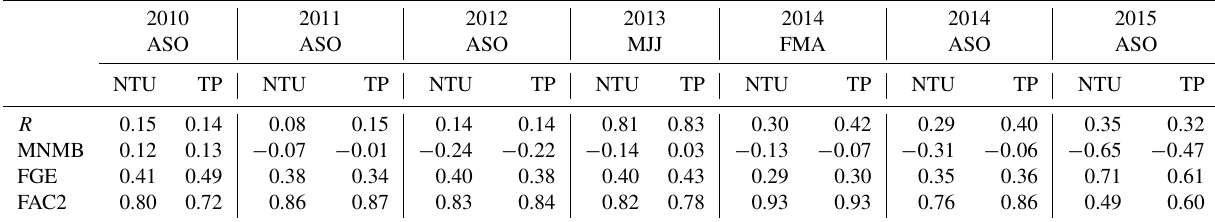
Table 4. Statistics for PM 10 , for both the western (NTU) and eastern (TP) monitoring stations, for selected 3-month haze seasons. The background concentration of 25µgm − 3 is subtracted from the observations for all stations for all seasons. The metrics considered are the Pearson correlation coefficient ( R ), the modified normalised mean bias (MNMB), the fractional gross error (FGE), and a factor of 2 (FAC2).